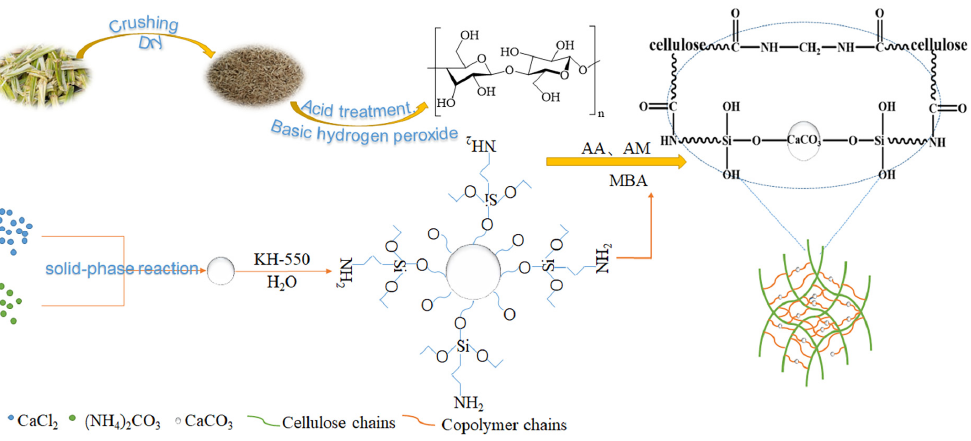
Figure 1. Preparation process of composite SAR CAAMC.